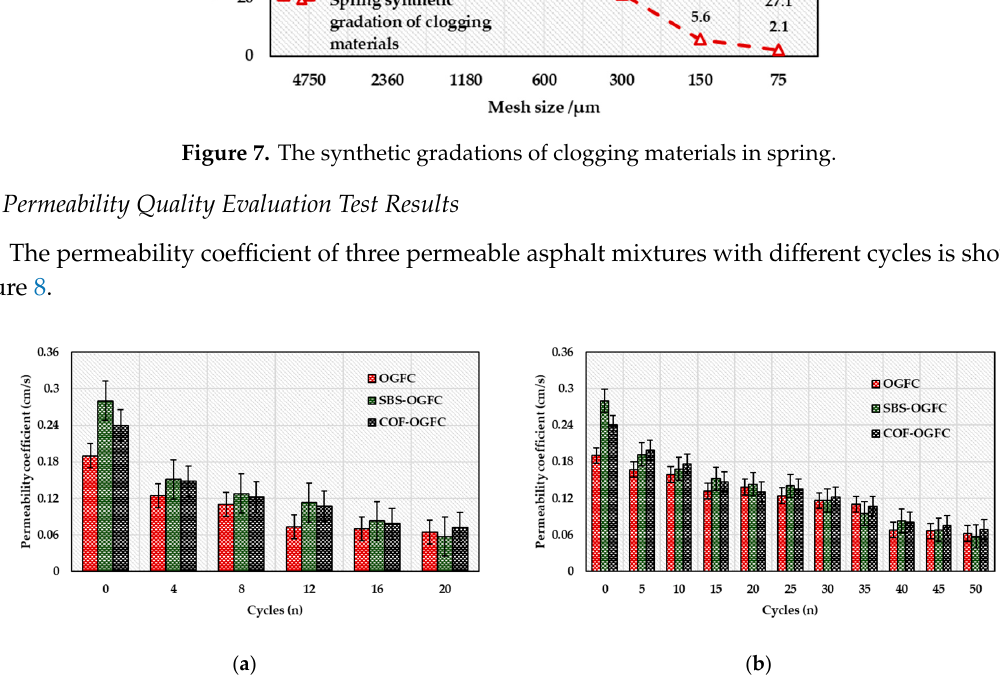
Figure 8. Permeability coefficient of three permeable asphalt mixtures with different cycles in spring and summer. ( a ) Spring clogging procedure; ( b ) Summer clogging procedure.